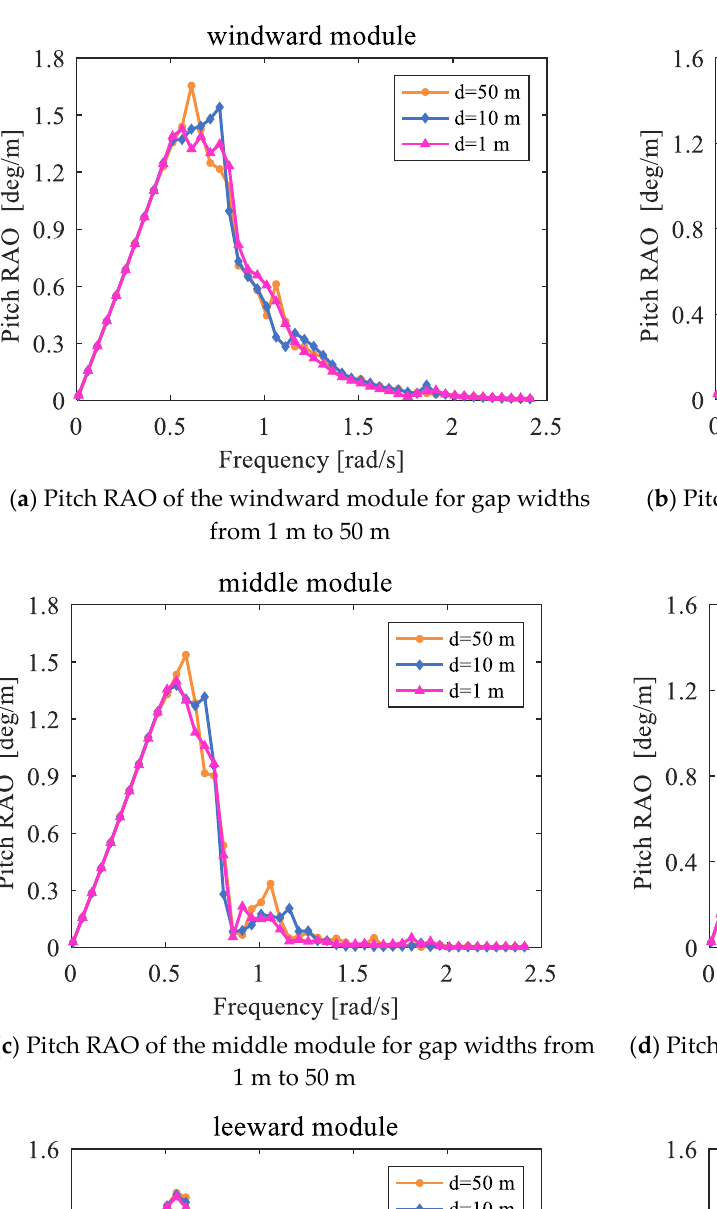
resonant frequency of the 3-module model increases with the decrease of the spacing, as